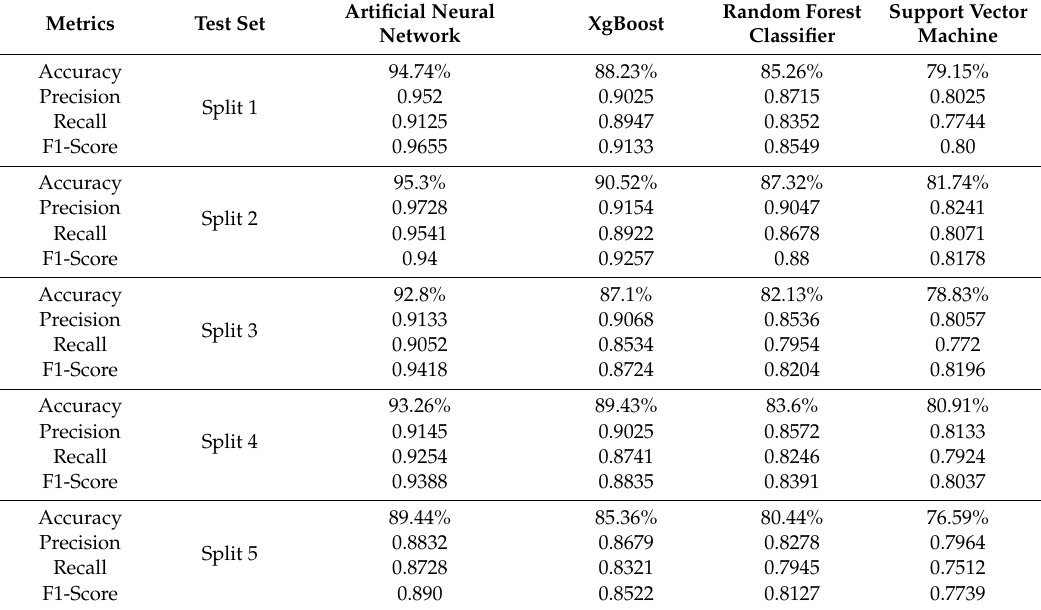
Table 10. Comparative analysis of the performance of machine learning classifiers and cross-validation results of the